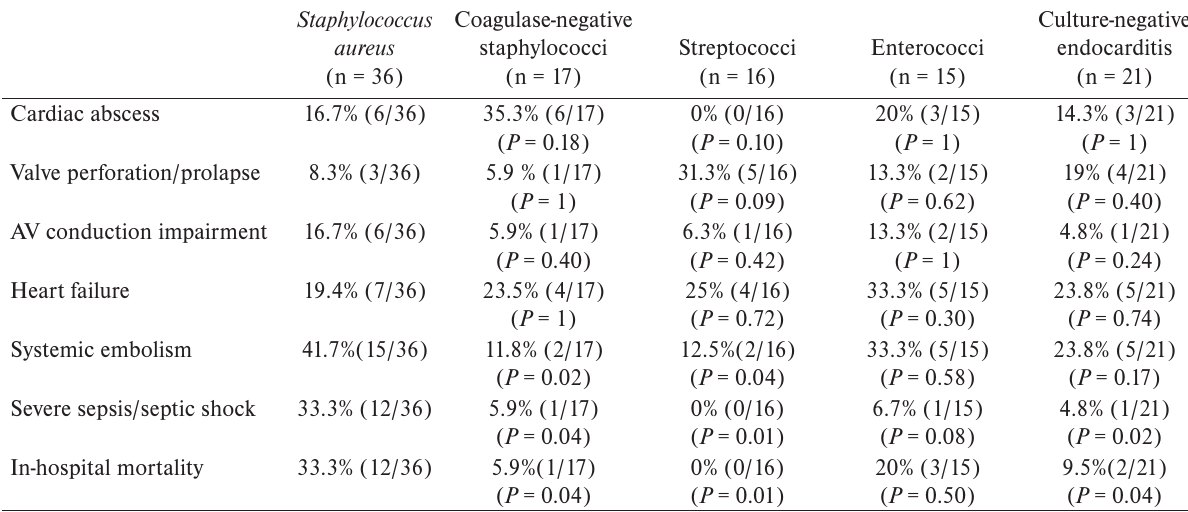
Table 6. Comparison of complications in the S. aureus group with the groups composed of the four major aetiological